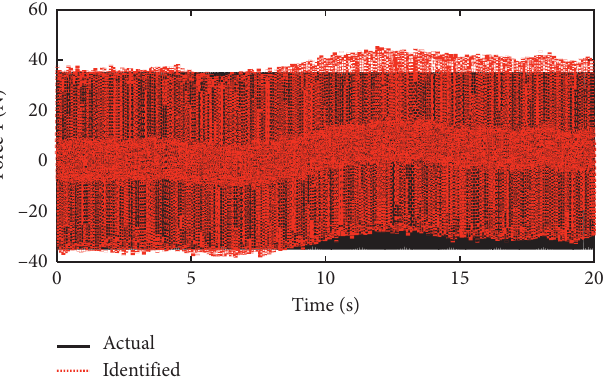
Figure 2: Identification of external load u